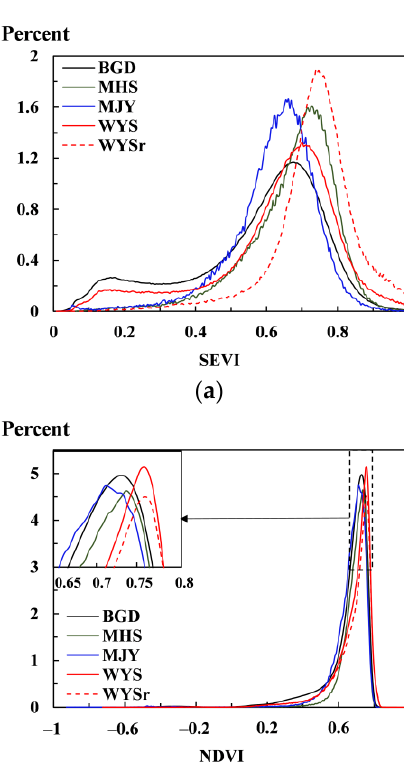
Table 2. SEVI mean of protected area and buffer zone (SEVI b ), slope mean, and years of establish- ment of protected area.